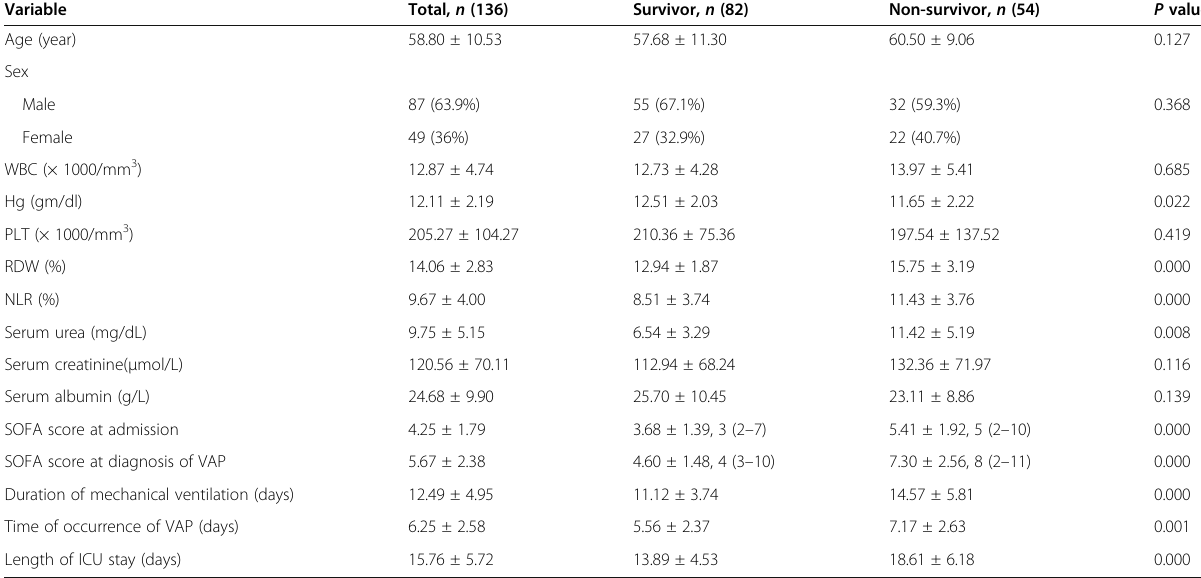
Table 1 Demographic characteristics, laboratory, and disease severity for the study population